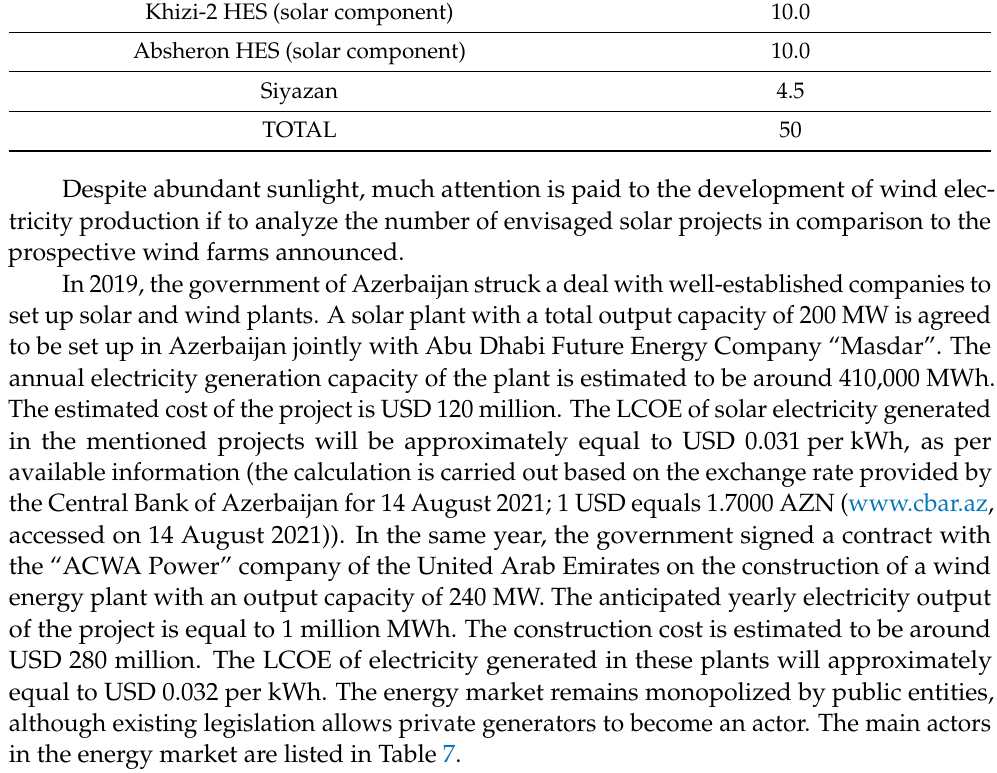
Table 7. Key energy market actors.